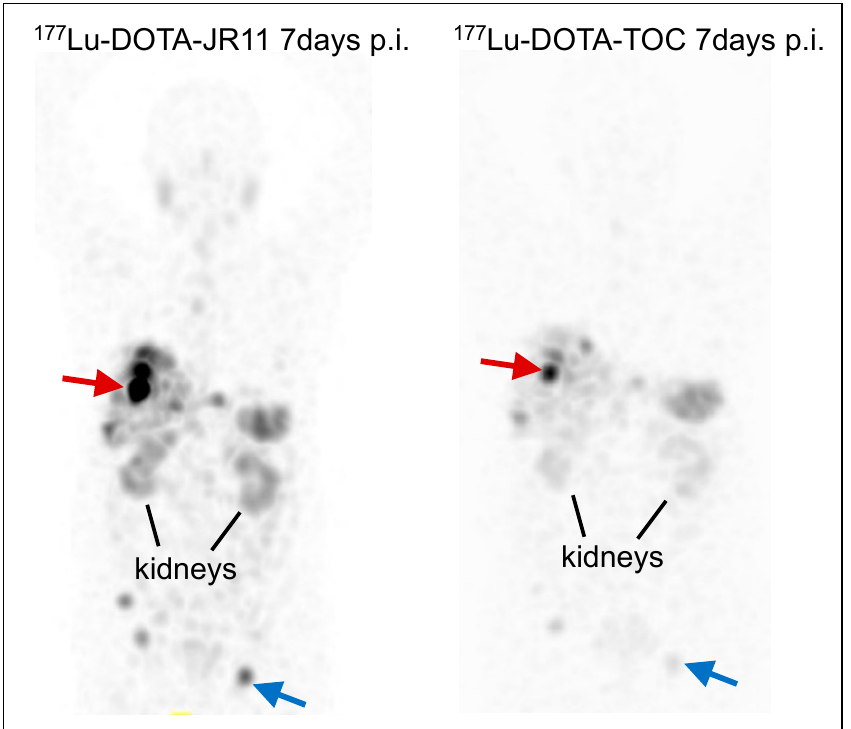
Figure 2. Multi-intensity projection SPECT of 177 Lu-DOTA-JR11 and 177 Lu-DOTA-TOC in the same patient with metastatic atypical lung carcinoid. Arrows show tumor doses of 177 Lu-DOTA-JR11 vs. 177 Lu-DOTA-TOC: red arrow: 12.6 vs. 3.36 Gy/GBq, blue arrow: 9.89 vs. 1.46 Gy/GBq.